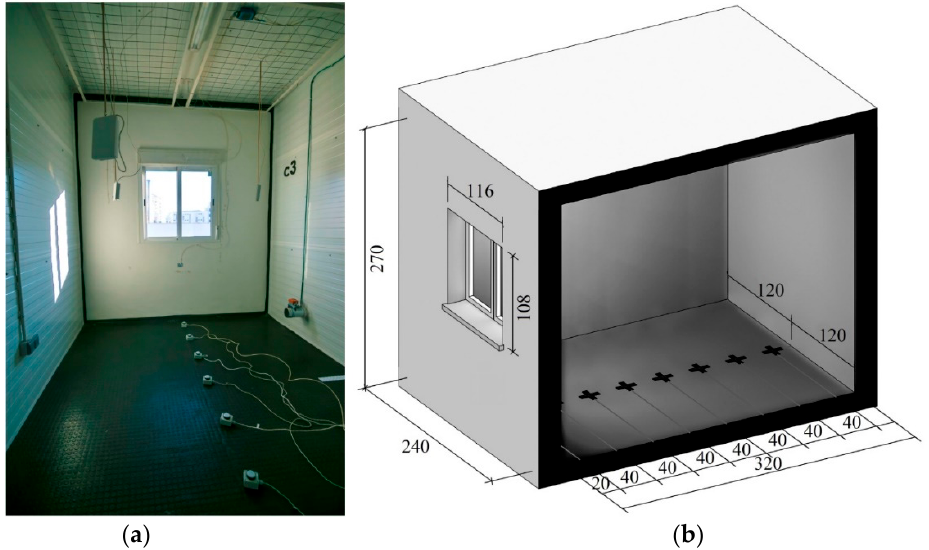
Figure 3. ( a ) Inner view of the test cell with sensor distribution, ( b ) virtual model with illuminance study points.